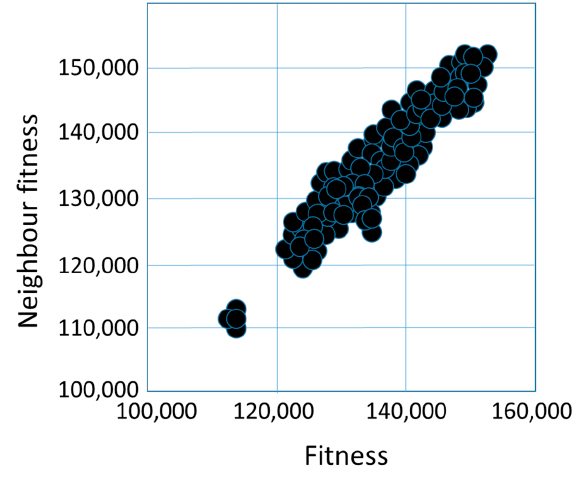
Figure 8. The fitness cloud for 2-opt operator. Table 6. 2-opt distances results.